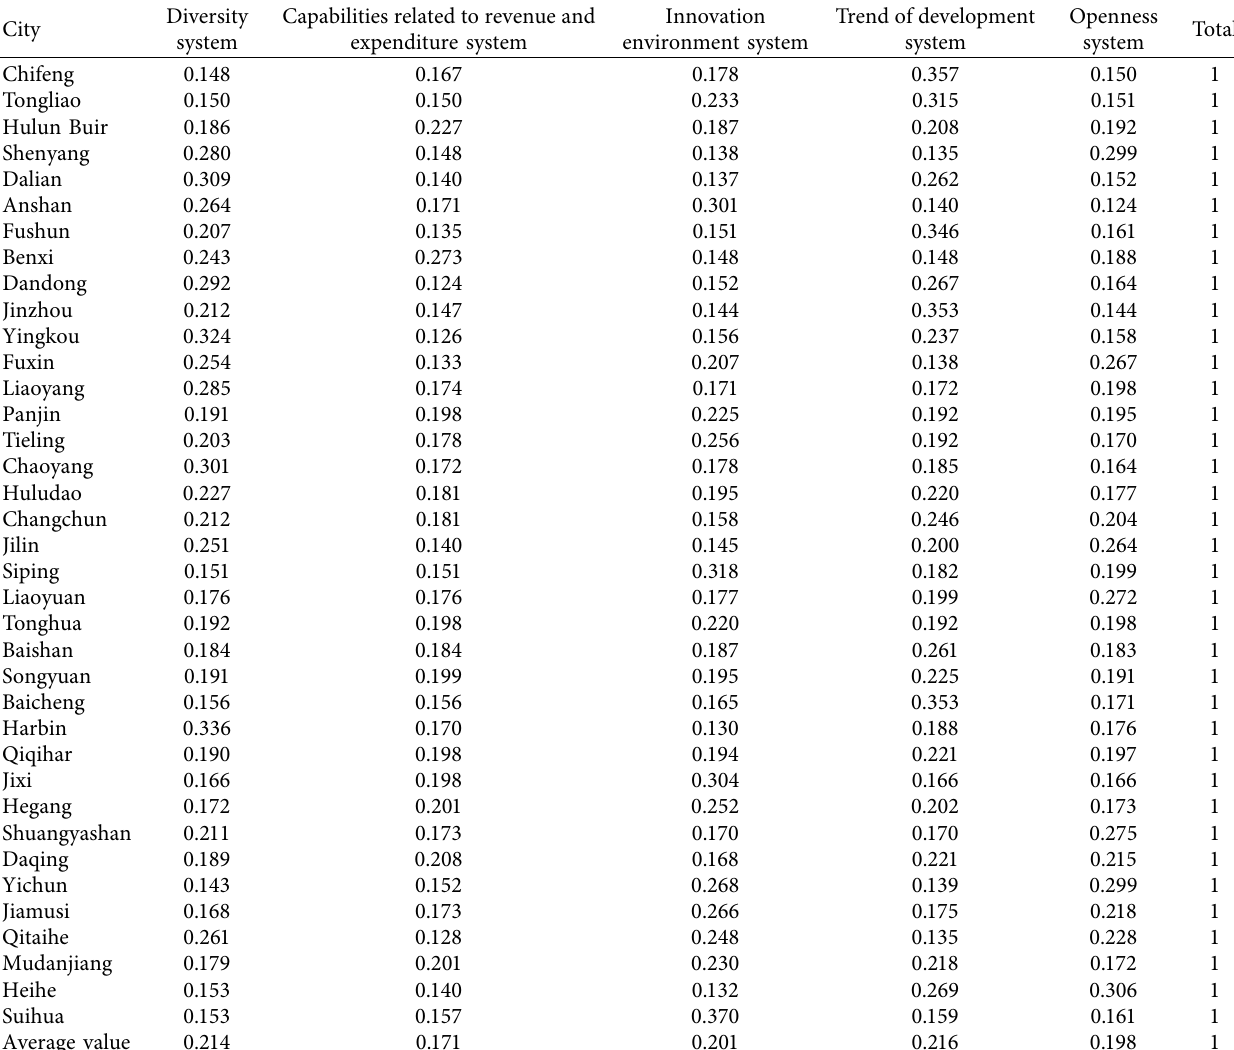
Table 3: Weights of the contribution of each subsystem on the economic resilience of cities in Northeast China.